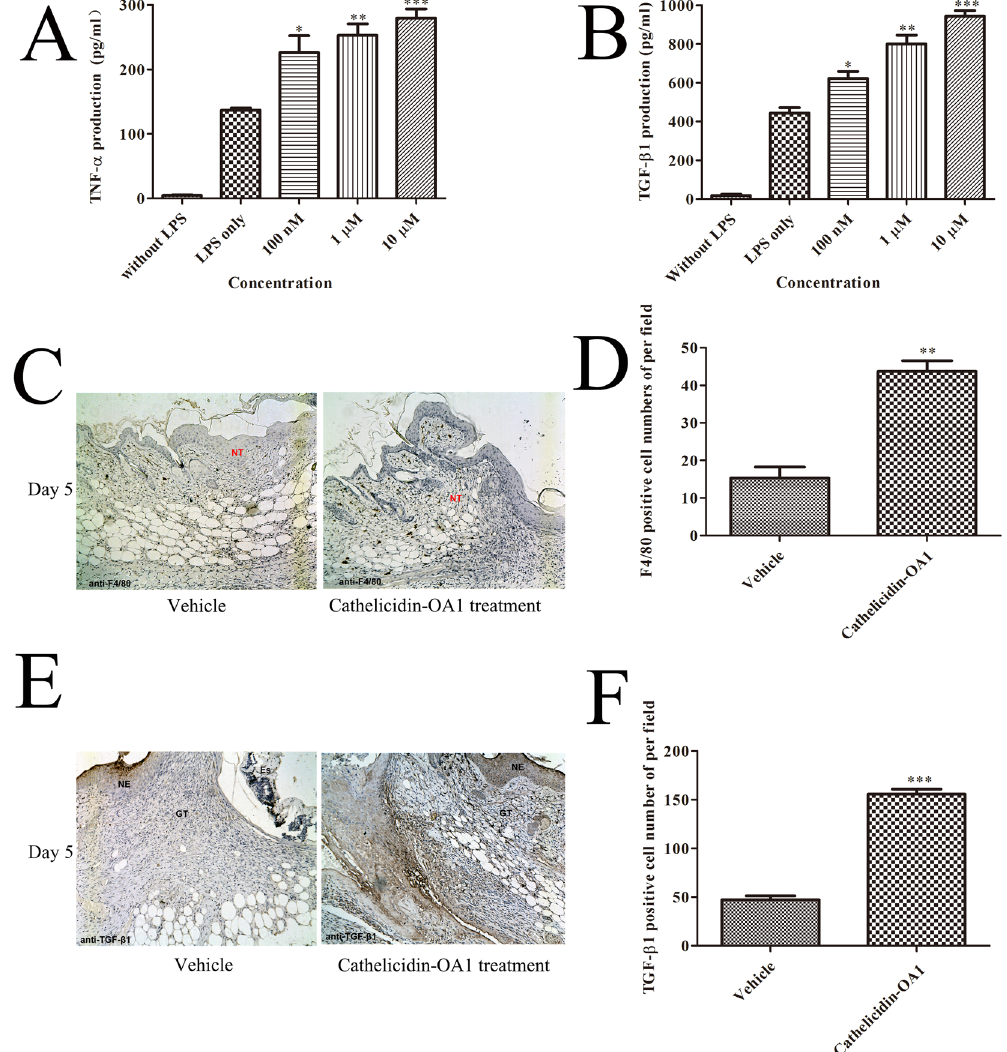
Figure 8. Cathelicidin-OA1 promoted the secretion of TNF- α and TGF- β , macrophages recruitment, TGF- β expression. ( A , B ) THP-1 cells were stimulated by LPS to secrete TNF- α and TGF- β 1. Incubation with cathelicidin-OA1 at different concentrations resulted in the dose-dependent increase in TNF- α and TGF- β 1 secretion. * P < 0.05, ** P < 0.01, and *** P < 0.0001 indicate significantly different from the negative control (Student’s t -test). Data are mean values of three independent experiments performed in triplicate. ( C , E ) Immunohistochemical results for anti-F4/80 and TGF- β 1. ( D , F ) F4/80 or TGF- β 1 positive cell numbers per high power field were significantly different between cathelicidin-OA1 treatment and the control. ** P < 0.01 and *** P < 0.0001. Data are mean values of three independent experiments performed in triplicate and six different fields for each section ( × 100).